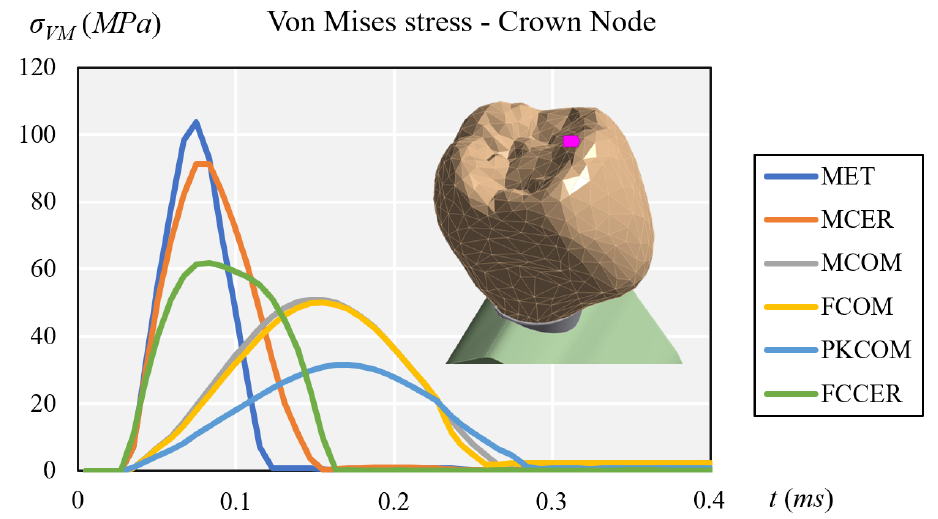
Figure 3. Comparison of equivalent von Mises stress at the crown node. At the same time, Figure 4 compares the displacement of each crown during impact.